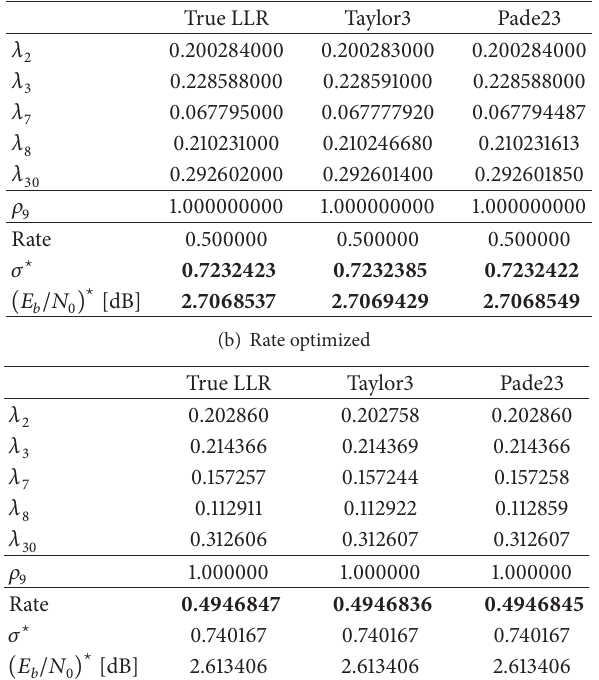
Table 3: Degree distribution profiles and their iterative thresholds for the uncorrelated flat Rayleigh fading channel with unknown CSI by the density evolution. These profiles are (a) threshold optimized and (b) rate optimized codes. The Shannon limit for rate half code is 𝜎 = 0.7436 ( 𝐸 𝑏 /𝑁 0 = 2.572 dB).